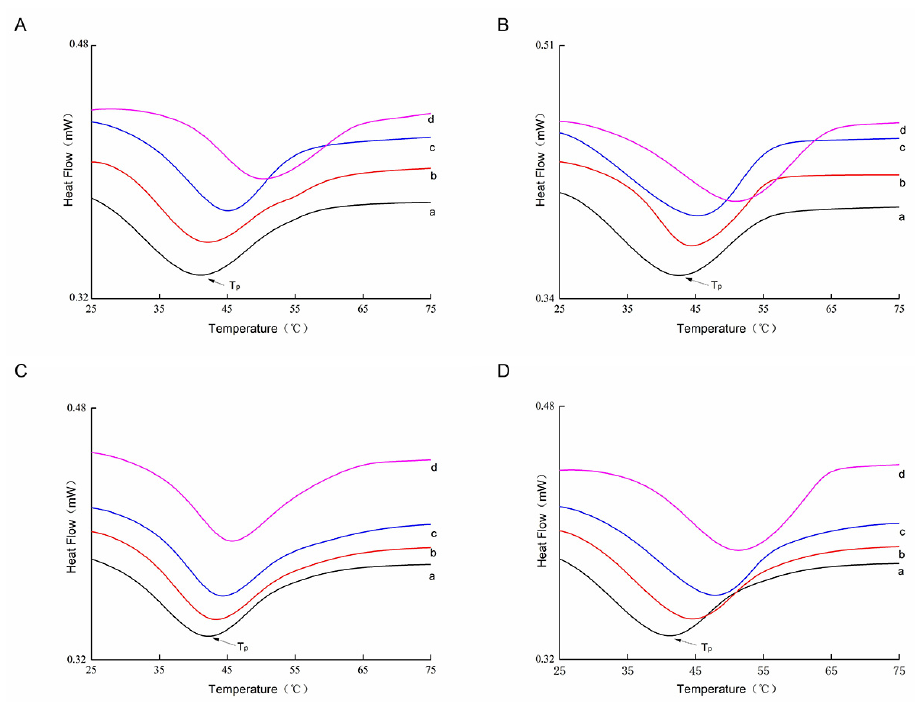
Figure 5. DSC analysis of type Ⅰ and Ⅲ collagen in the semitendinosus (SD) and longissimus dorsi (LD) muscles in different growth stages. ( A , B ) represent type Ⅰ collagen from the SD and LD; ( C , D ) represent type Ⅲ collagen from the SD and LD; and a, b, c, and d represent 6, 9, 12, and 18 months of age, respectively. Table 3. DSC analysis of type Ⅰ and Ⅲ collagen in Semitendinosus (SD) and Longissimus dorsi (LD) in different growth stages.